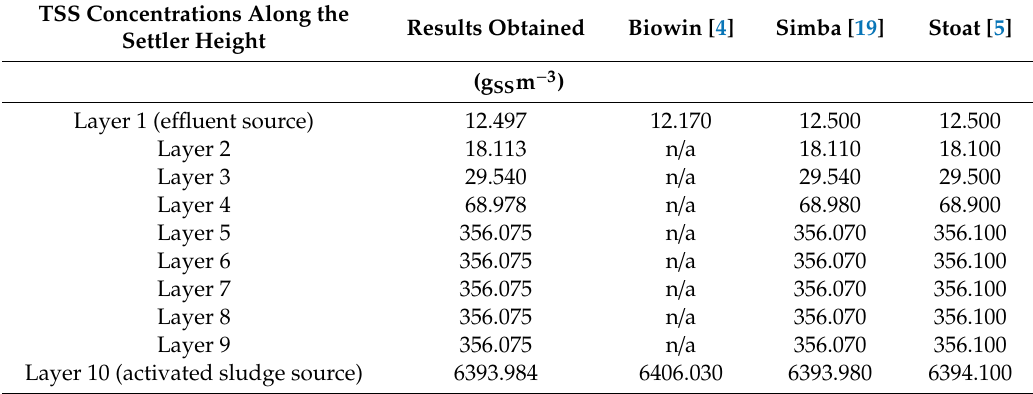
Table 3. Comparison of the total suspended solids (TSS) concentrations in the clarifier with commercial software (n / a = not